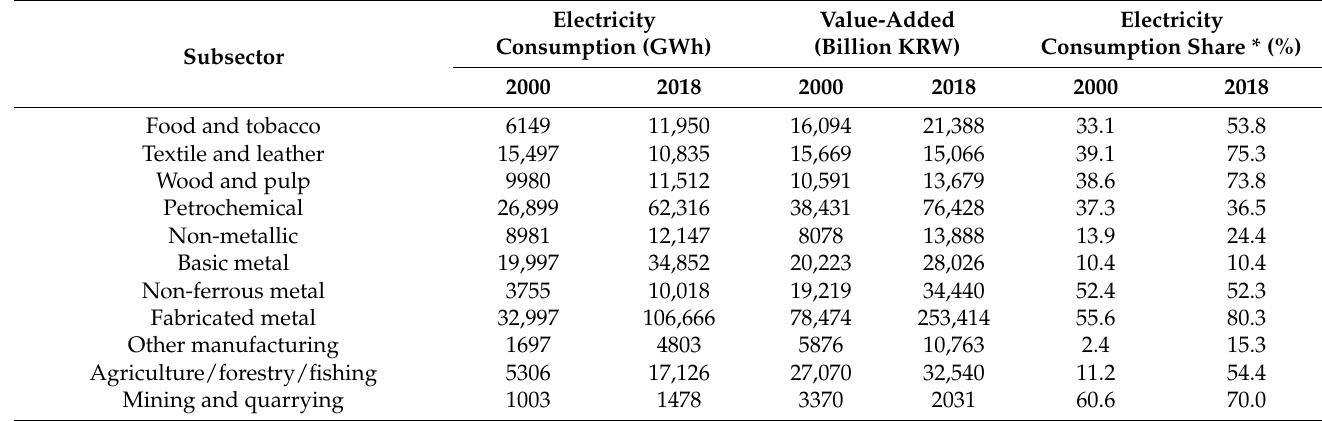
Table 1. Electricity consumption, value added, and shares in 2000 and 2018.